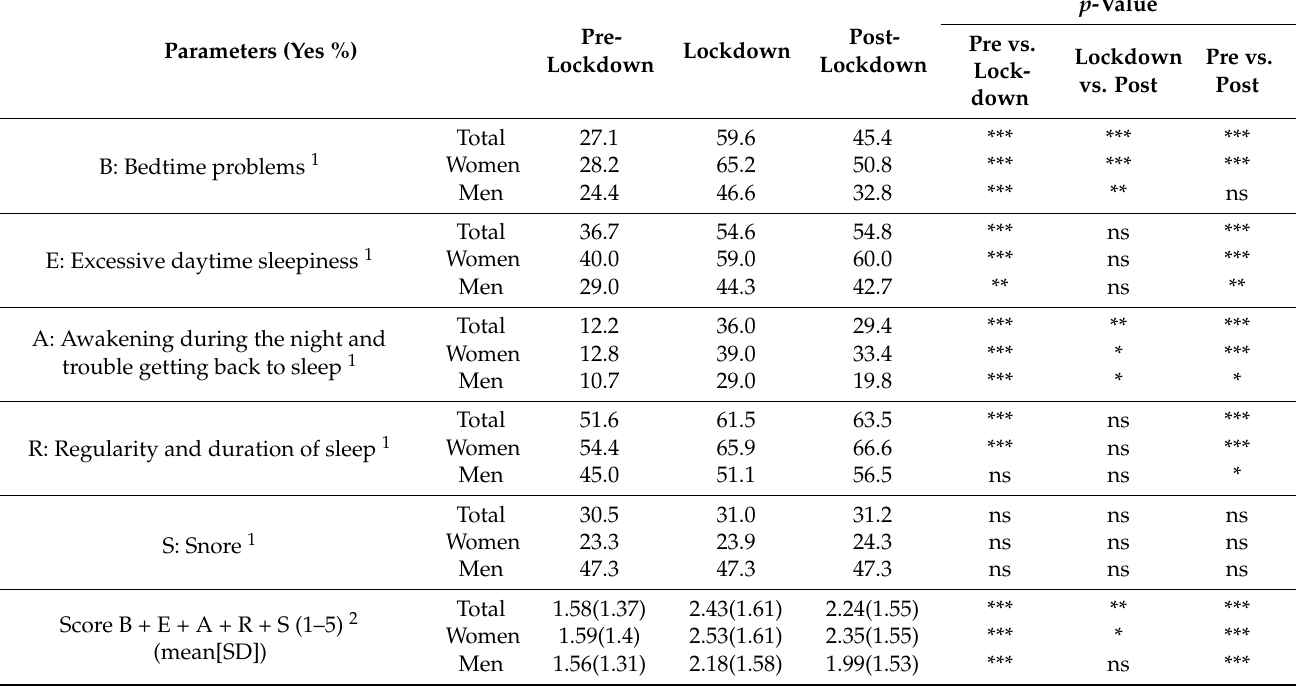
Table 2. Sleep BEARS